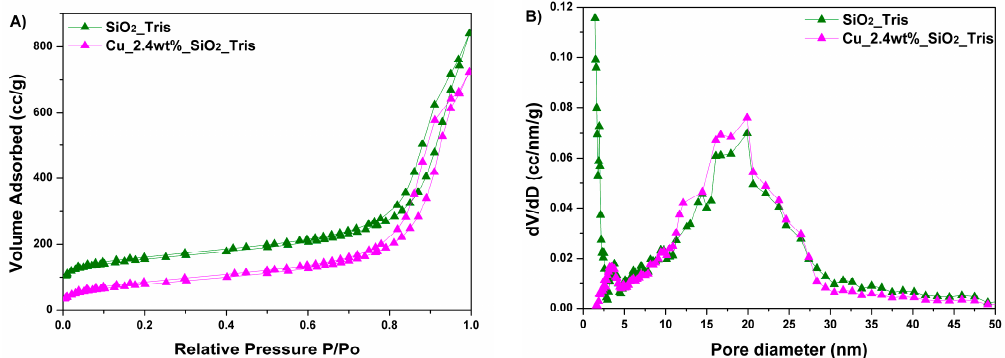
Figure 9. Isotherm plots ( A ) and PSD curves ( B ) of samples produced with Tris buffer.